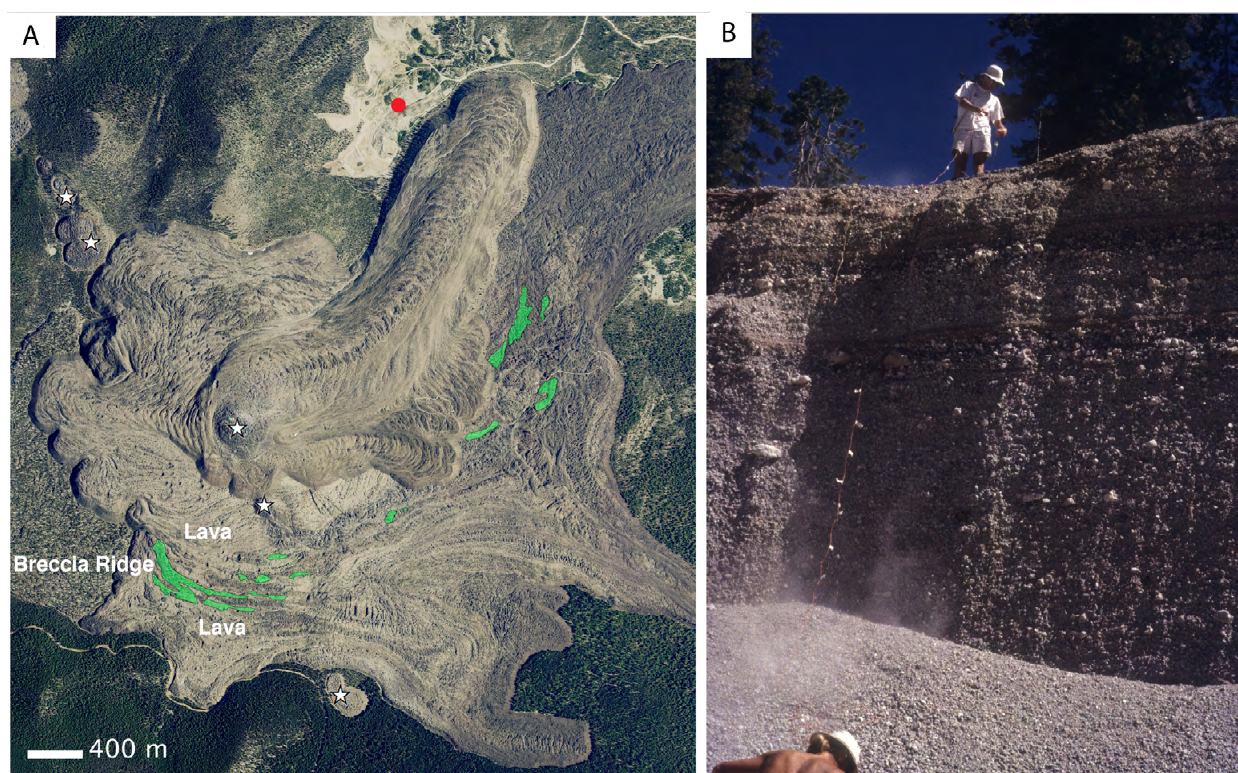
Figure 1: [A] Satellite image of Big Glass Mountain (BGM), northern California. North direction is up in image. Imagery dates from 29 June 2017 and is provided by the National Agricultural Imagery Program (NAIP/USDA- FSA). Obsidian lava of BGM occupies most of the field of view, however co-eruptive air-fall deposits are apparent in vegetated land and in the quarry to the NW of the BGM flow. White stars show the approximate locations of vents within the flow and on the extension of the presumed fissure system [e.g. Eichelberger 1975]. The red dot shows the approximate location of our pyroclastic samples, collected in 1997. Green areas superimposed on the flow demarcate breccia ridges, which host significantly more vegetation than the normal flow top lava. Breccia ridges are particularly well exposed and positioned inboard of the southern and westernmost flow fronts, indicating that they were incorporated into the flow at some point after the onset of effusive activity [B] Close-up view of the ~2.5-m-tall outcrop of pumice and obsidian fall. We sampled this section at 15 cm intervals (shown by white tape markings on section line). Mapping by Chesterman [1955] suggests the total fallout section thickness is 3.6 m at this